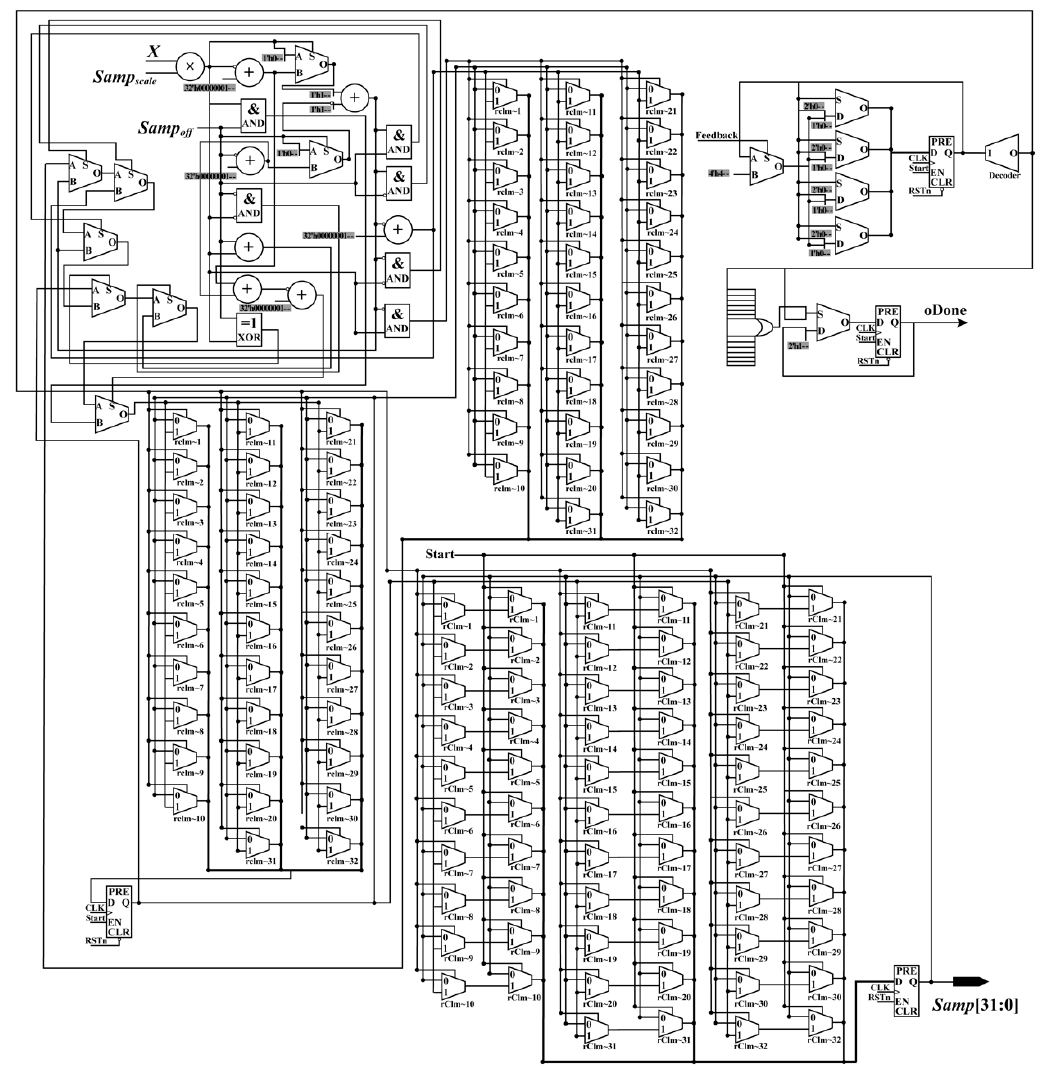
Figure 9. Schematic diagram used for calculating Samp coordinate.